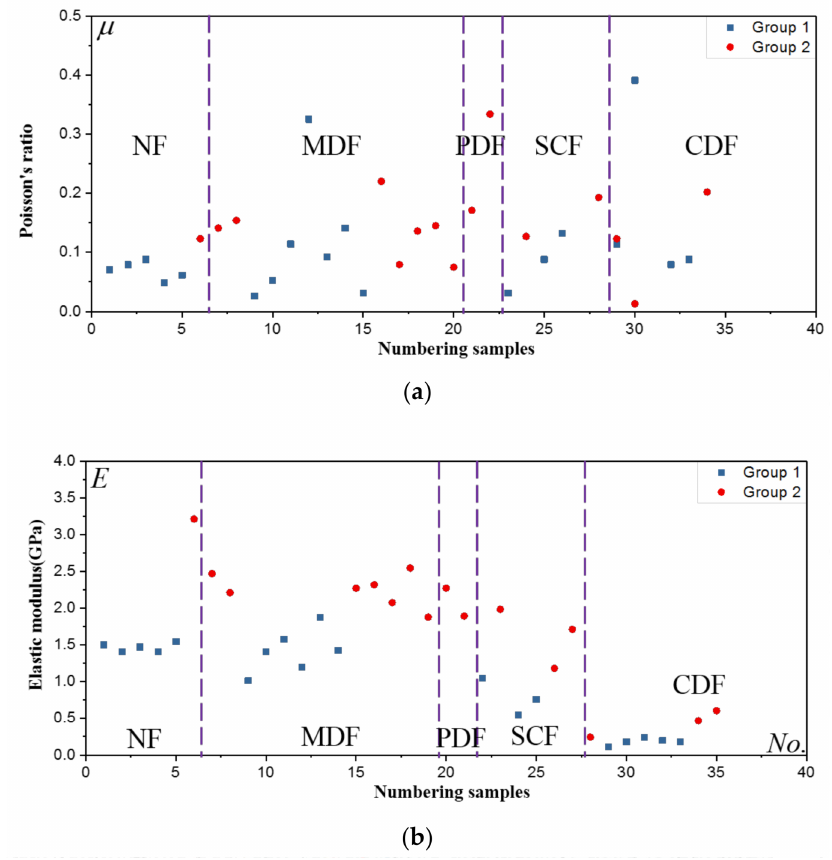
Figure 7. Distribution of elastic parameters. ( a ) Poisson’s ratio. ( b ) Elastic